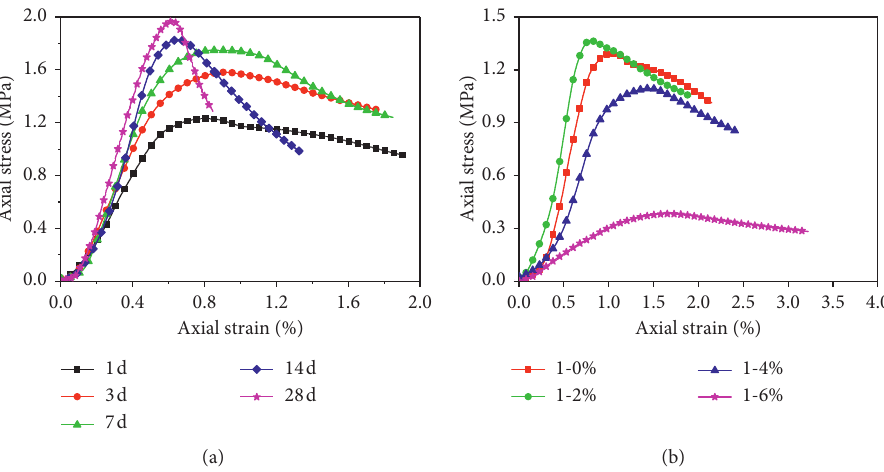
Figure 2: Typical stress-strain curves of MK-cemented silty clay. (a) MK0 at different curing times. (b) Curing time 1d with different MK contents.